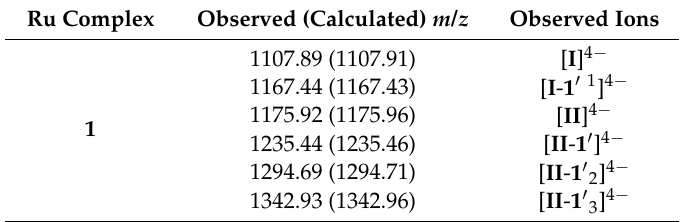
Figure 5. ( A ) HPLC chromatograms with ultraviolet (UV) detection at 260 nm for the reaction mixture of duplex III with complex 1 ( i ) or complex 4 ( ii ) (Ru/ III = 1.0) in 50 mM TEAA buffer (pH 7) and 100 mM NaClO 4 incubated at 310 K for 48 h; ( B ) mass spectra for HPLC fractions shown in ( A ); ( C ) circular dichroism (CD) spectra of free duplex III (black) and the reaction mixtures of duplex III with complex 1 (red), 2 (green), 4 (blue) and cisplatin (magenta) incubated at 310 K for 24 h at a molar ratio of Ru/ III or Pt/ III = 6.0. Table 4. Negatively-charged ions observed by ESI-MS coupled to denatured HPLC for reaction mixture of Ru complex 1 or 4 with duplex III (Ru/ III = 6.0, III = I + II ). For chromatograms and mass spectra, see Figures S10 and S11 in supplementary